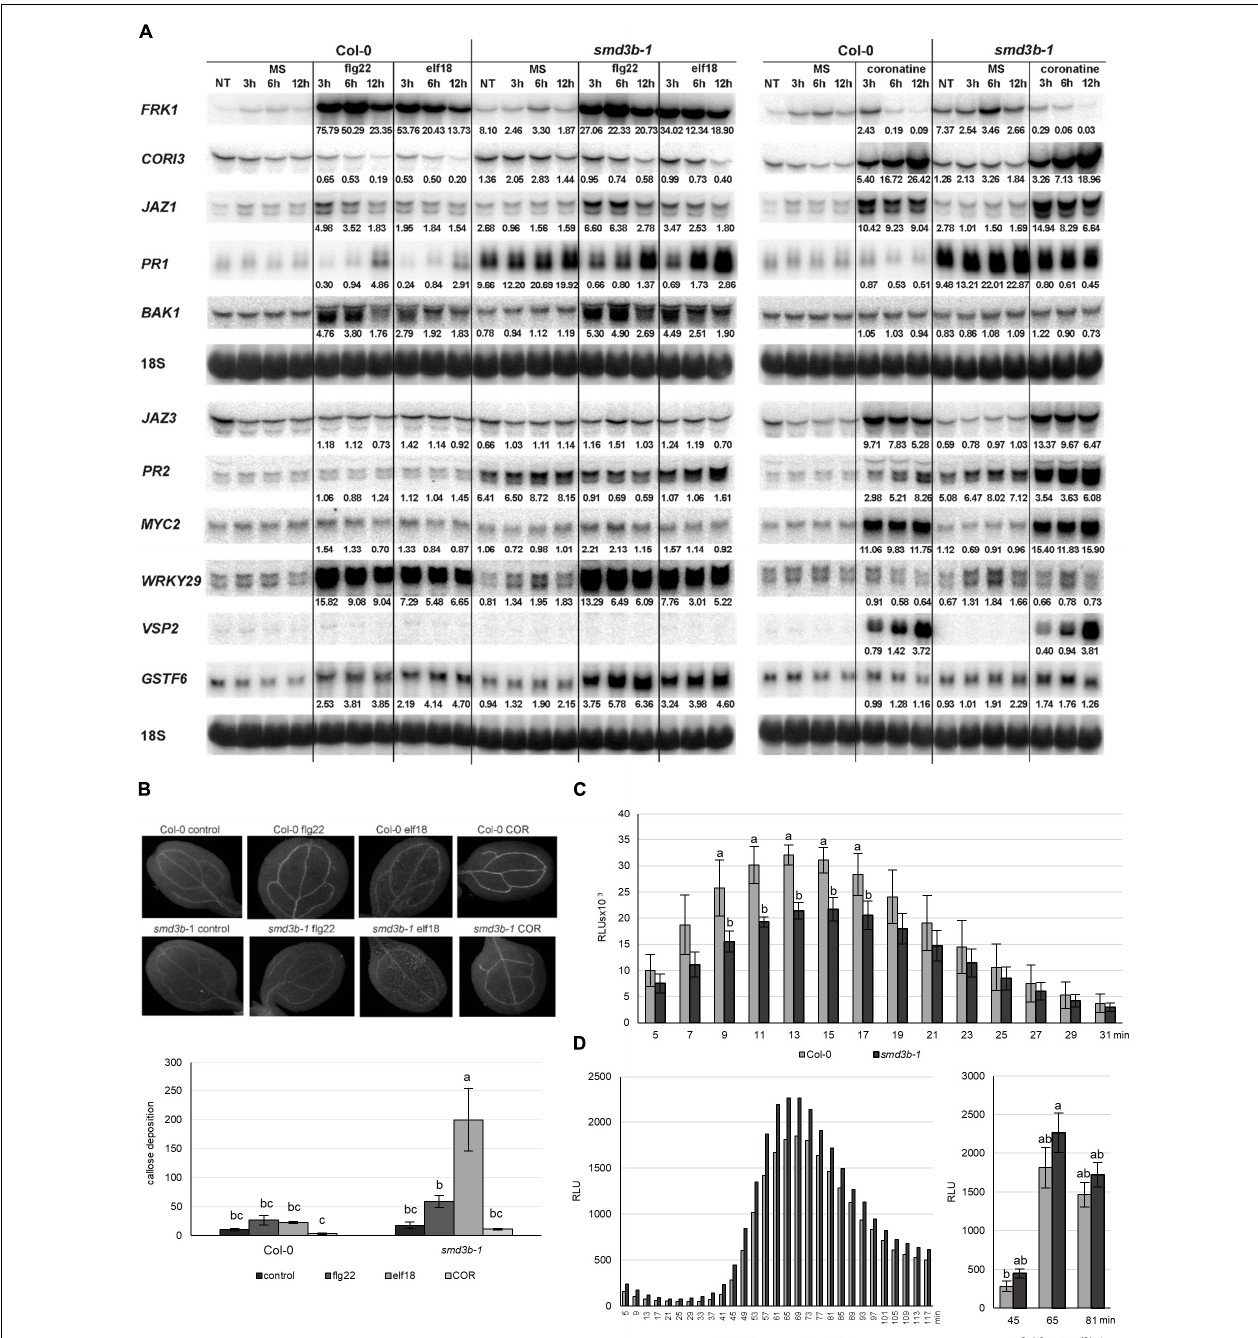
FIGURE 4 | Pathogen-associated molecular patterns (PAMP)-induced expression of pathogenesis markers, callose deposition and production of ROS is altered in the smd3b-1 mutant. (A) Northern blot analysis of factors involved in PAMP response. Samples were collected at indicated time points from non-treated (NT) 14-day -old seedlings, treated with MS (control) or 100 nM of flg22, elf18 and COR. The ratio of transcript level in treated Col-0 and smd3b-1 relative to control (MS) and the ratio of control smd3b-1 vs. Col-0 is shown as numbers. Values were normalized to 18S rRNA loading control. Experiments were repeated four times; representative blots are shown. (B) One-week-old plants were treated with MS (control) or 1 µ M of flg22, elf18 and COR. Callose formation was visualized by aniline blue staining and epifluorescence microscopy and quantified using ImageJ software from digital photographs as a number of local maxima specified by the average of RGB colored pixels (callose intensity) in plant material. Bars represent mean of three independent biological replicates with error bars showing SD ; letters represent significant difference ( P < 0.05) for Tukey’s HSD test. Representative pictures are shown. (C,D) ROS production in response to 100 nM flg22 (C) or Pst (D) treatment in leaf disks from 6-week-old Col-0 and smd3b-1 plants. (C) Bars represent mean of four independent biological replicates with error bars showing SD , with Student’s t -test. (D) Letters represent significant difference ( P < 0.05) for Tukey’s HSD test. Luminescence is in Relative Light Units (RLUs).